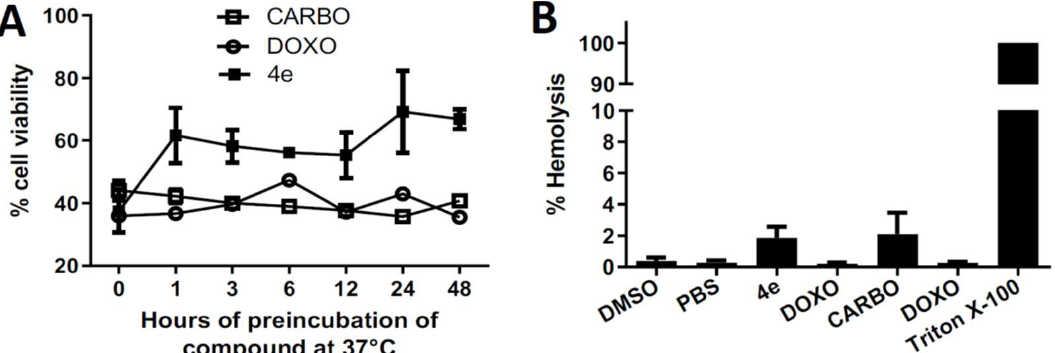
Figure 3. Determination of stability and induced hemolysis of the most selective naphthoquinone compound ( 4e ) in OSCC cells. SCC9 cells were used for both assays. ( A ) For the stability test, compound 4e and the control carboplatin were diluted to 2 × IC 50 and maintained at 37 °C for 1, 3, 6, 12, 24, and 48 h prior to SCC9 cells treatment for a further 48 h followed by MTT assay. ( B ) The hemolytic activity of compound 4e was carried out using the concentration of 300 µM (approximately 10 × IC 50 ). One-way ANOVA with Dunnett’s Posttest was performed where all columns were significantly different from the control (Triton X) with p < 0.0001.